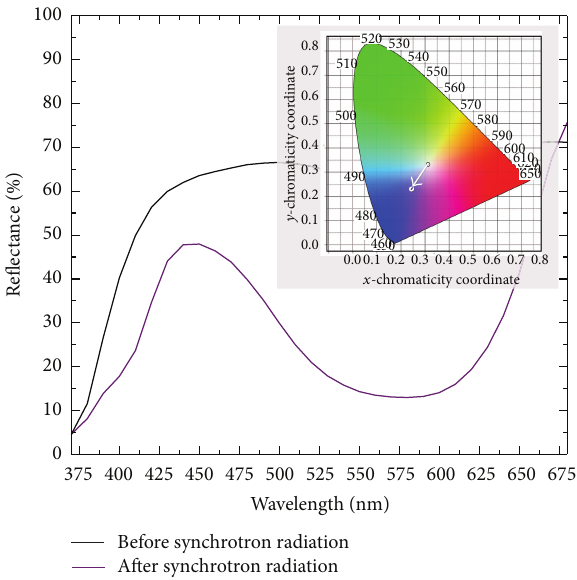
Figure 4: Reflectance spectra of the SP/BaFCl:Eu 2+ PC composite film before and after synchrotron radiation for 2s. The inset shows color shift in the CIE1931 chromaticity diagram at the maximum brightness. Color coordinates of the composite film are shown as open